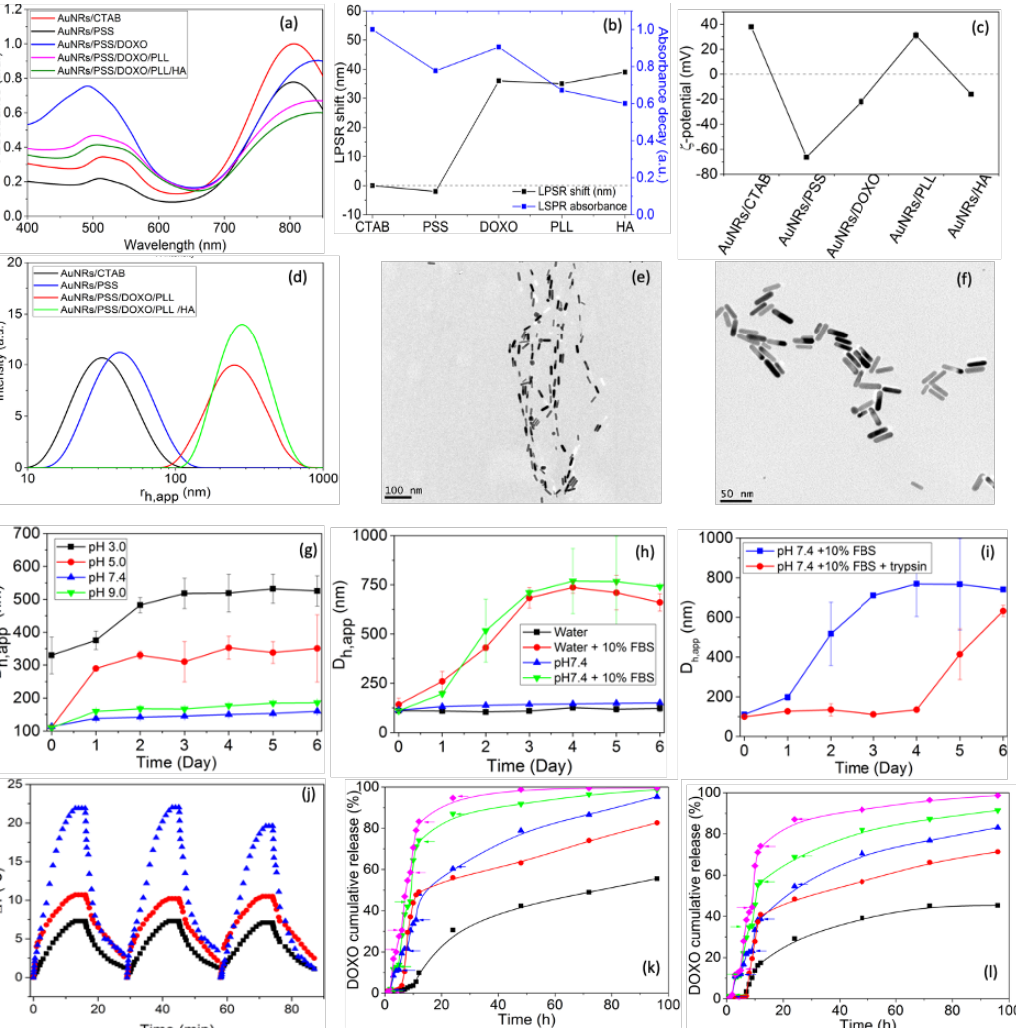
Figure 3. Changes in ( a ) absorption spectra, ( b ) LPSR absorbance and position, ( c ) surface charge, and ( d ) population size distributions of AuNRs after the different polymeric coating steps. TEM images of ( e ) CTAB-coated and ( f ) PSS/PLL-DOXO/HA-coated AuNRs. Colloidal stability of PSS/PLL/HA-coated AuNRs by monitoring the time evolution of platform hydrodynamic sizes at ( g ) different pH, ( h ) in the absence and presence of serum, and ( i ) of trypsin at 37 °C. Samples were diluted in buffers of pH 3.0 ( ), 5.0 ( ), 7.4 ( ), and 9.0 ( ). ( j ) Temperature increments after successive irradiation cycles at ( ), 1.0 ( ), 2.0 ( ) and 3.0 W/cm 2 using an 808 NIR laser light. DOXO release profiles from PSS/DOXO/PLL/HA-coated AuNRs at ( k ) pH 5.0 and ( l ) 7.4 alone ( ), or in the presence of trypsin ( ), NIR light (1.0 W/cm 2 for 5 min, at 2, 5, 9, 12 and 24 h ( ), trypsin + NIR light of 1.0 W/cm 2 (similar time points, ) and trypsin + NIR light of 2.0 W/cm 2 (similar time points, ). Errors bars in release plots are not shown for clarity, but uncertainties are below 15%. Arrows denote the time points of NIR light application.